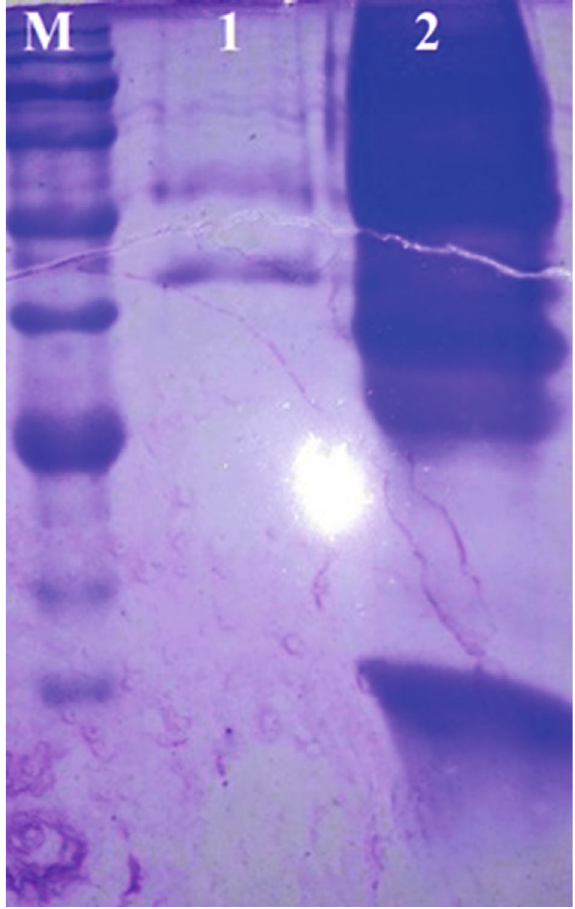
Figure 1: SDS-PAGE of ke fi r microorganism. M: marker 1. Sedimentation of cell lysate 2. Lysate.